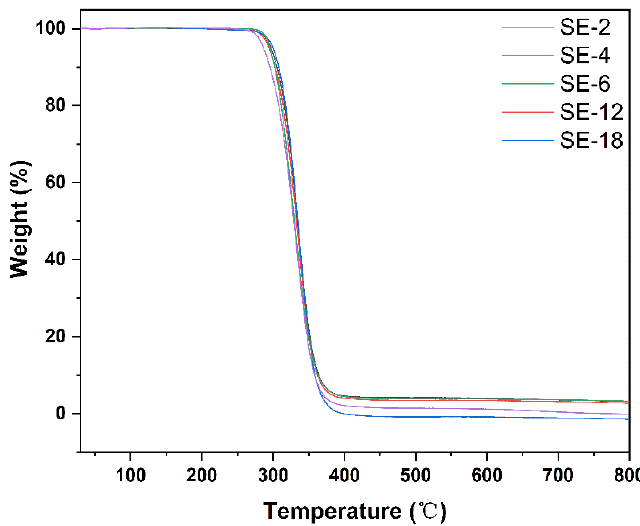
Figure 4. TGA curves of SE-2, SE-4, SE-6, SE-12 and SF-18 at a heating rate of 10 °C min − 1 in nitrogen.